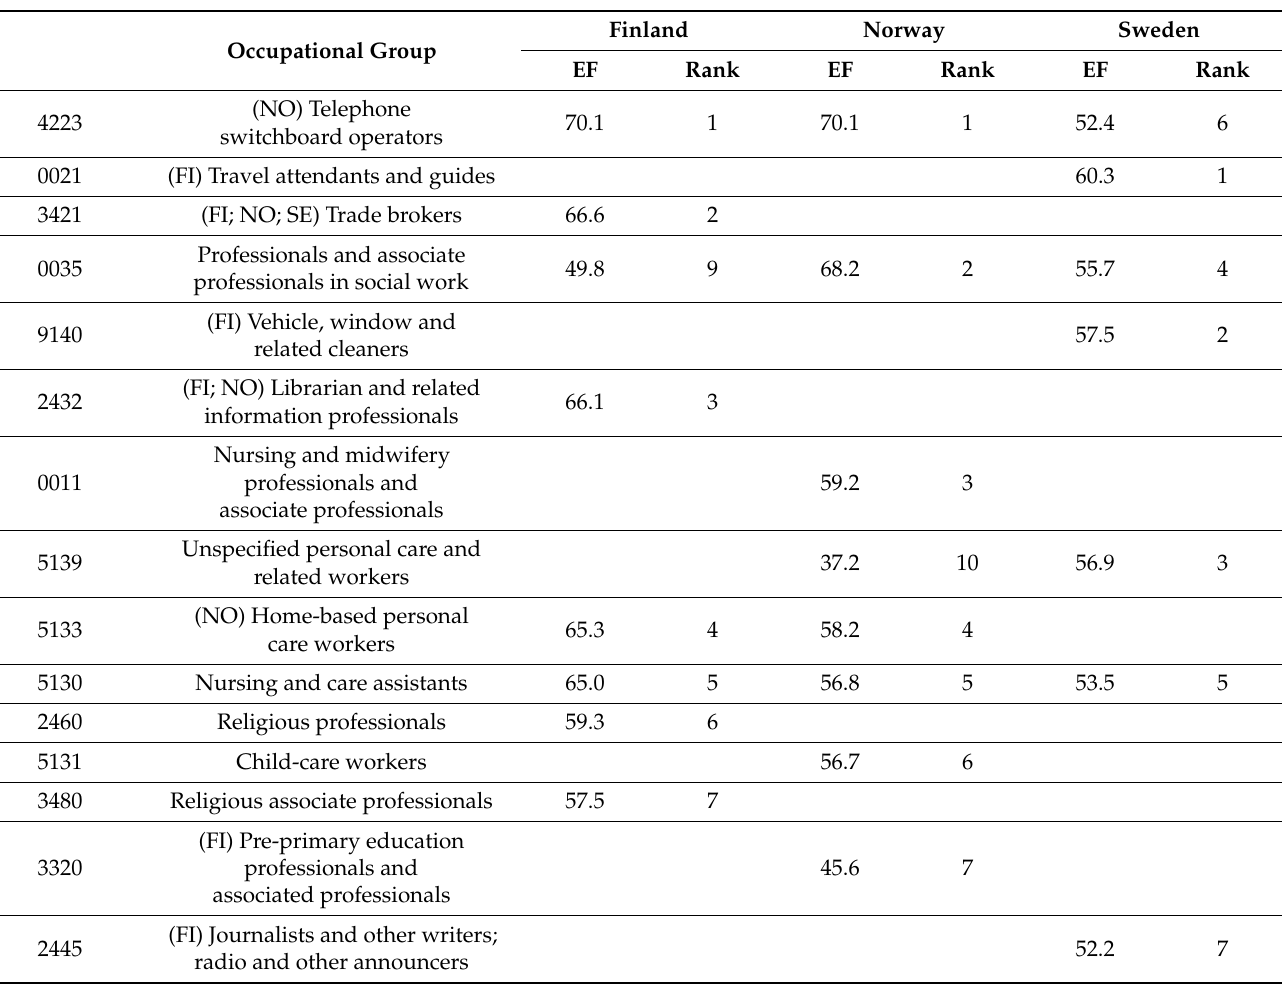
Table 4. Occupational groups with rank 1–10 based on the excess fraction (EF, %) of the